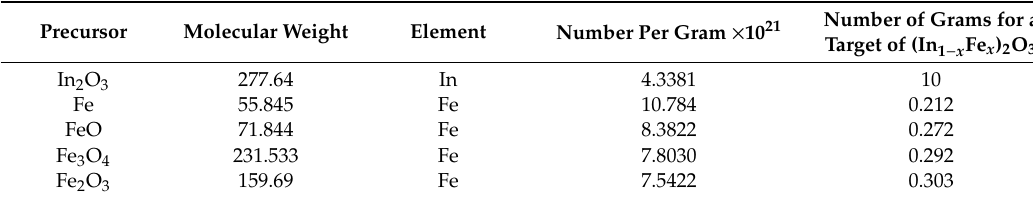
Table 1. The weight of each material required to make targets weighing ~11